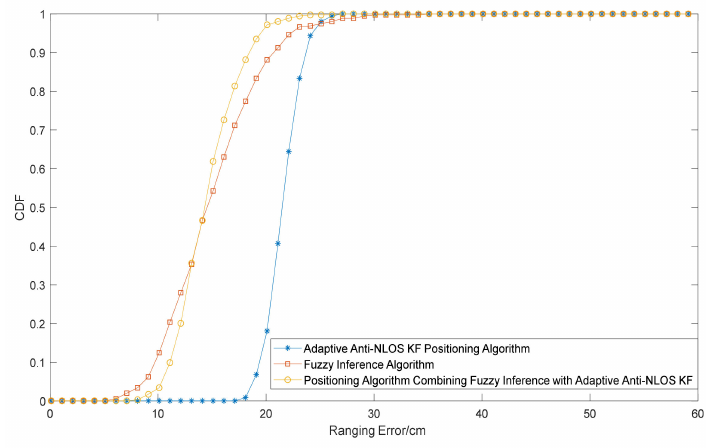
Figure 8. CDF diagram of the three positioning